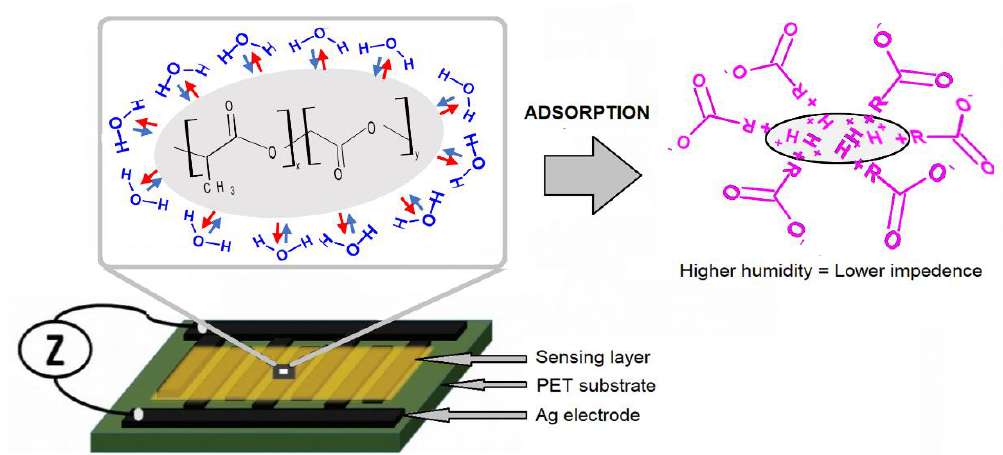
Figure 9. Humidity sensing mechanism. (Adapted with permission from [30], Copyright 2019, Springer Nature).